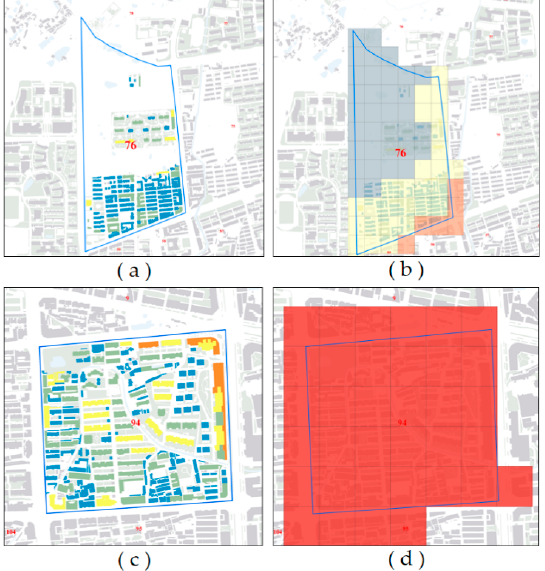
Figure 6. Partial comparison of redistributed population and WorldPop estimation results: ( a ) population distribution at block 76 at the building scale; ( b ) WorldPop population distribution in block 76; ( c ) population distribution at the building scale in block 94; ( d ) WorldPop population distribution in block 94.